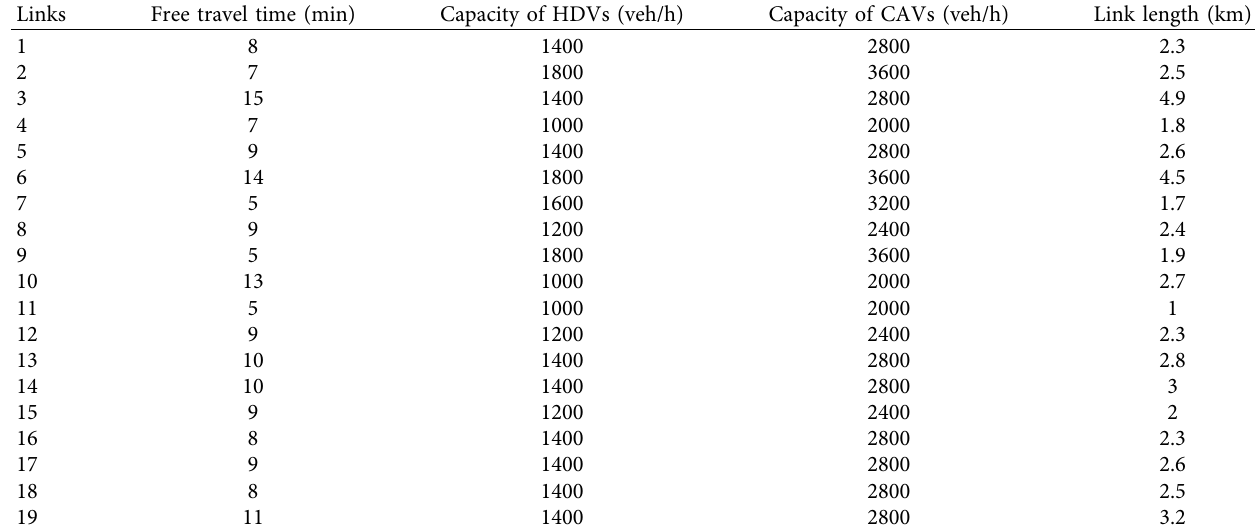
Table 3: Characteristic parameters of road network link.